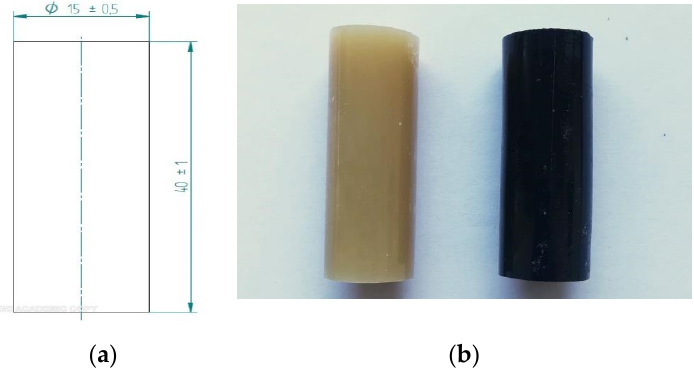
Figure 1. ( a ) Epoxy specimen dimensions (unit: mm); ( b ) cured epoxy specimens: E57/PAC/100:80/CaCO 3 (left), E57/PAC/100:80/C (right).